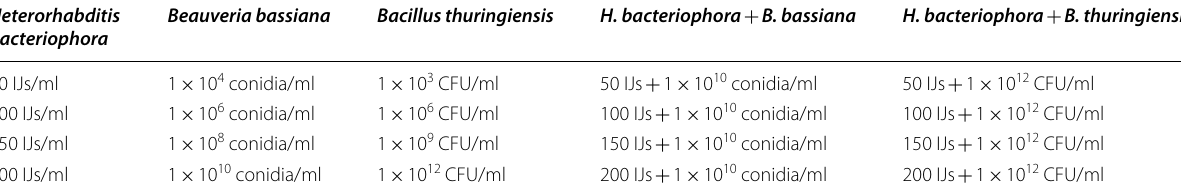
Table 1 List of tested entomopathogens applied against 3rd instar larvae of Spodoptera litura under laboratory conditions Heterorhabditis bacteriophora